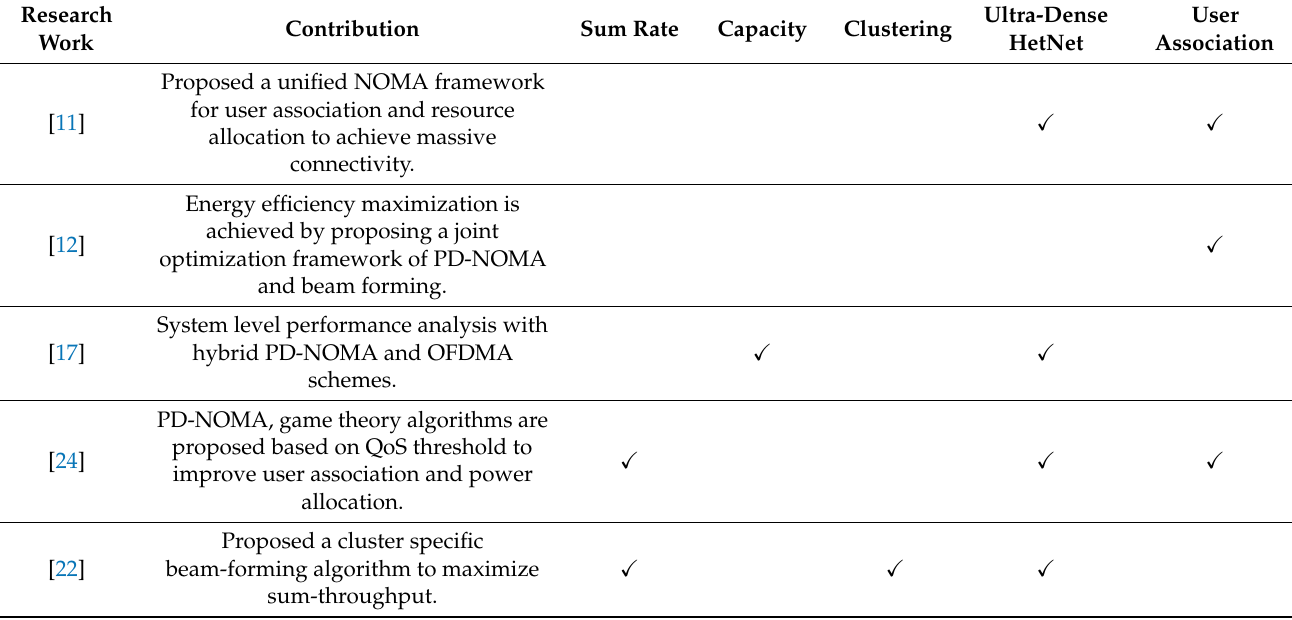
Table 1. Existing literature performed with